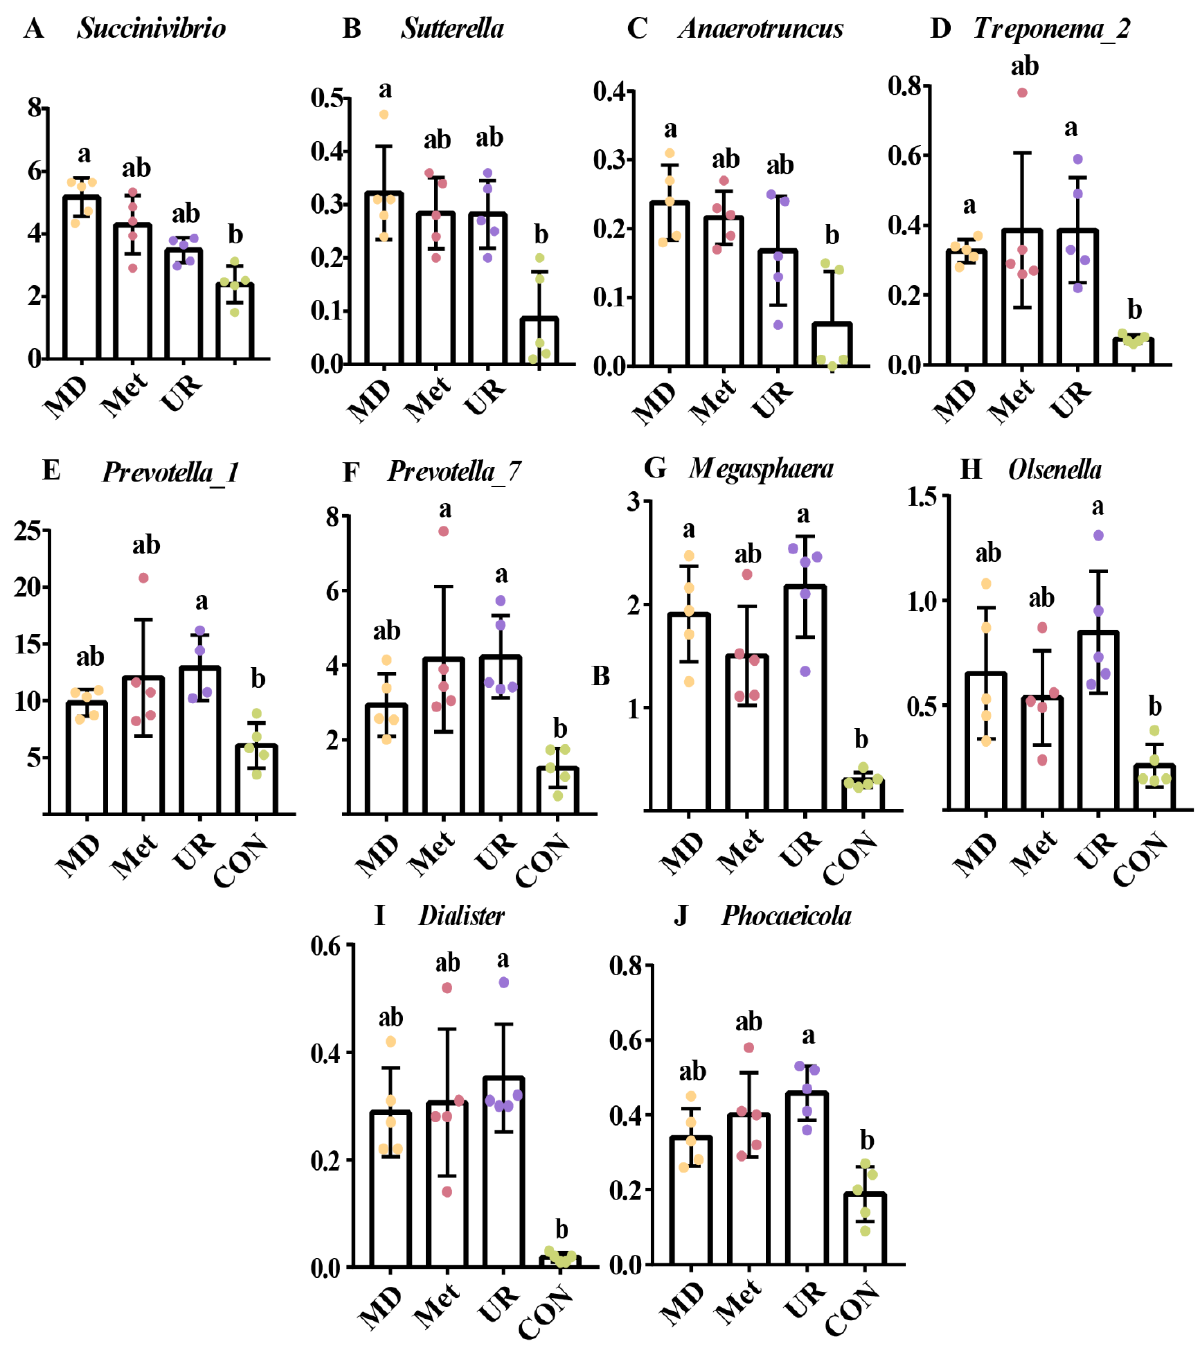
Figure 7. The significantly different genera response to methionine dipeptide ( A – C ), methionine ( D ), and urea ( E – J ) supplementation. CON = no additive, UR = urea addition, Met = methionine addition, and MD = methionine dipeptide addition. These genera were tested by linear discriminant analysis effect size and the relative abundance analyzed in detail by the Kruskal–Wallis test. Means with different letters (a, b) are significantly different ( p < 0.05). Vertical bars denote standard deviation (SD); n = 5 per treatment per time.